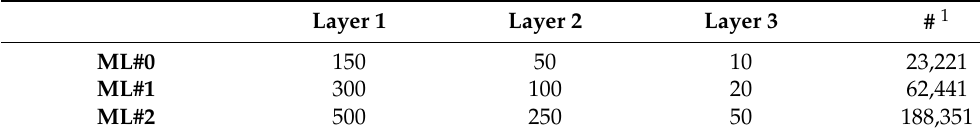
Figure 6. Probability density of the errors obtained by fully-connected networks. The errors are the differences between the predicted tunes and the resonances used to simulate the spectra. Table 1. Model architectures presented for fully-connected